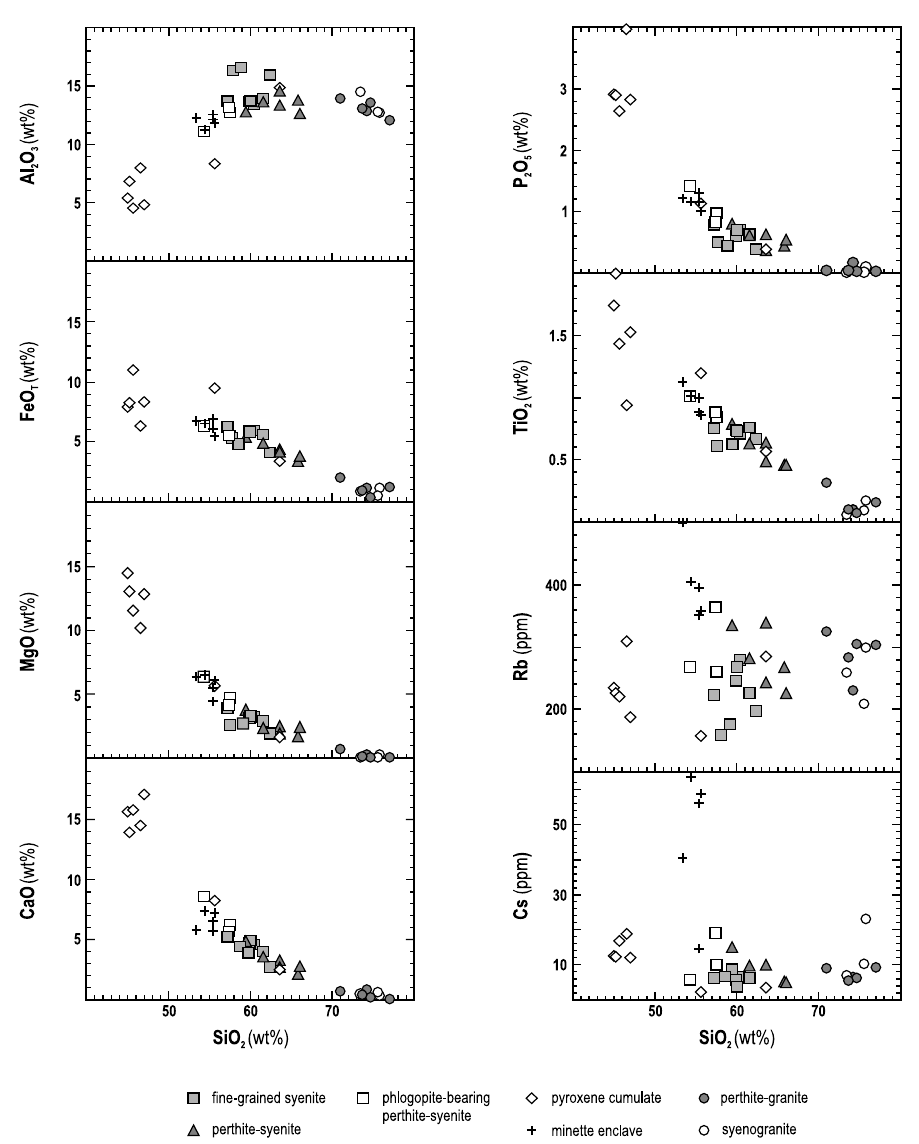
Fig. 3 – Harker diagrams for some major and trace elements in Piquiri Syenite Massif